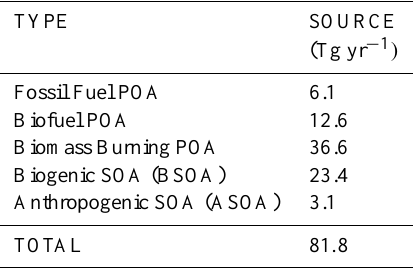
Table 2. Annual global organic aerosol sources in GEOS-Chem simulation for year